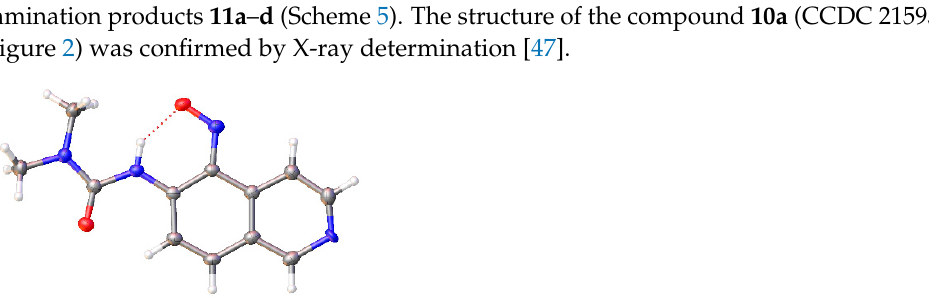
Figure 2. ORTEP diagram of nitroso compound 10 а . The crystallographic data could be found in the Supplementary Materials.